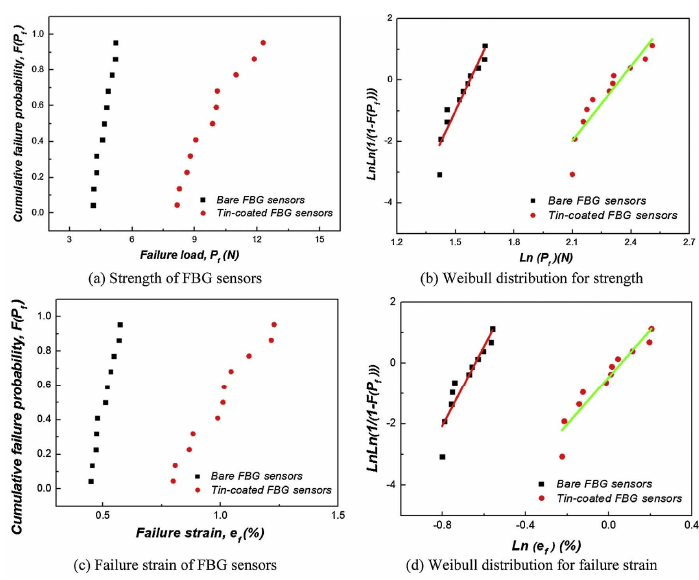
Figure 9. Comparison of failure parameters of bare FBG sensors and tin-coated FBG sensors [50].